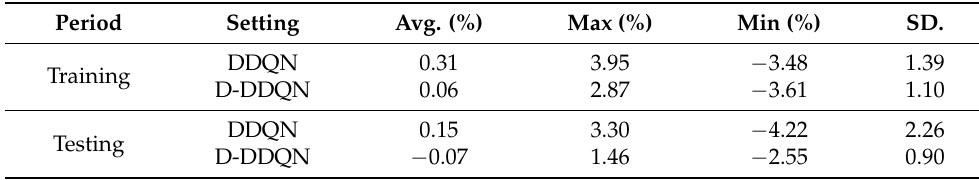
Table 3. Average return performance with return reward function.